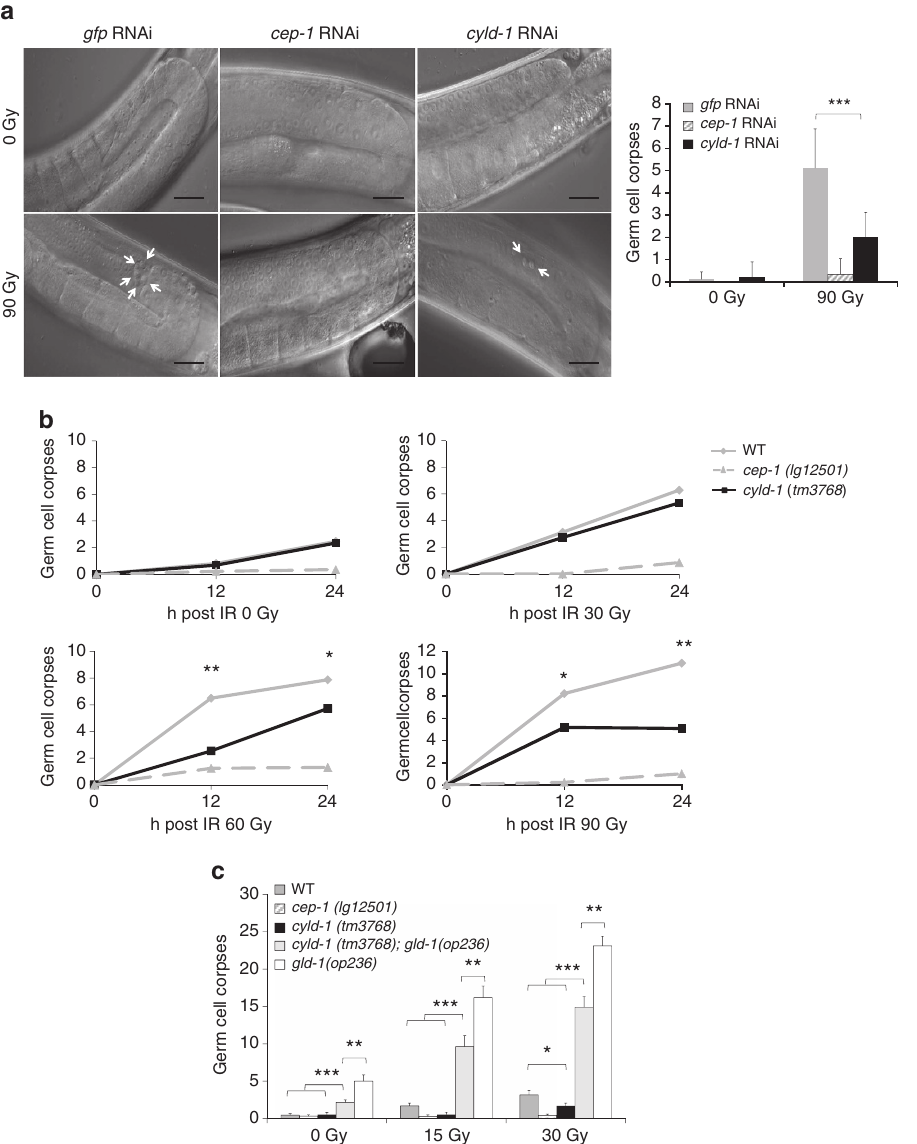
Figure 5 | CYLD regulates CEP-1/p53-dependent cell death upon DNA damage in C. elegans . ( a ) Representative pictures showing the pachytene region of the germline and quantification of corpses formation 24h after 90 Gray (Gy) irradiation from cep-1 and cyld-1 RNAi fed worms (arrows indicate apoptotic corpses). Data shown as mean ± s.d is shown. Statistical significance was determined with Student’s t -test; *** P r 0.0005. Scale bars, 20 m m. ( b ) Quantification of germ cell corpses in the indicated worm lines after irradiation. One representative out of three independent experiments is shown. Data shown as mean. Statistical significance was determined with Student’s t -test; * P r 0.05, ** P r 0.005. ( c ) Quantification of germ cell corpses in the indicated worms 24h after irradiation. Data shown as mean ± s.d. is shown. Statistical significance was determined with Student’s t -test; * P r 0.05, ** P r 0.005, *** P r 0.0005. One representative out of three independent experiments is